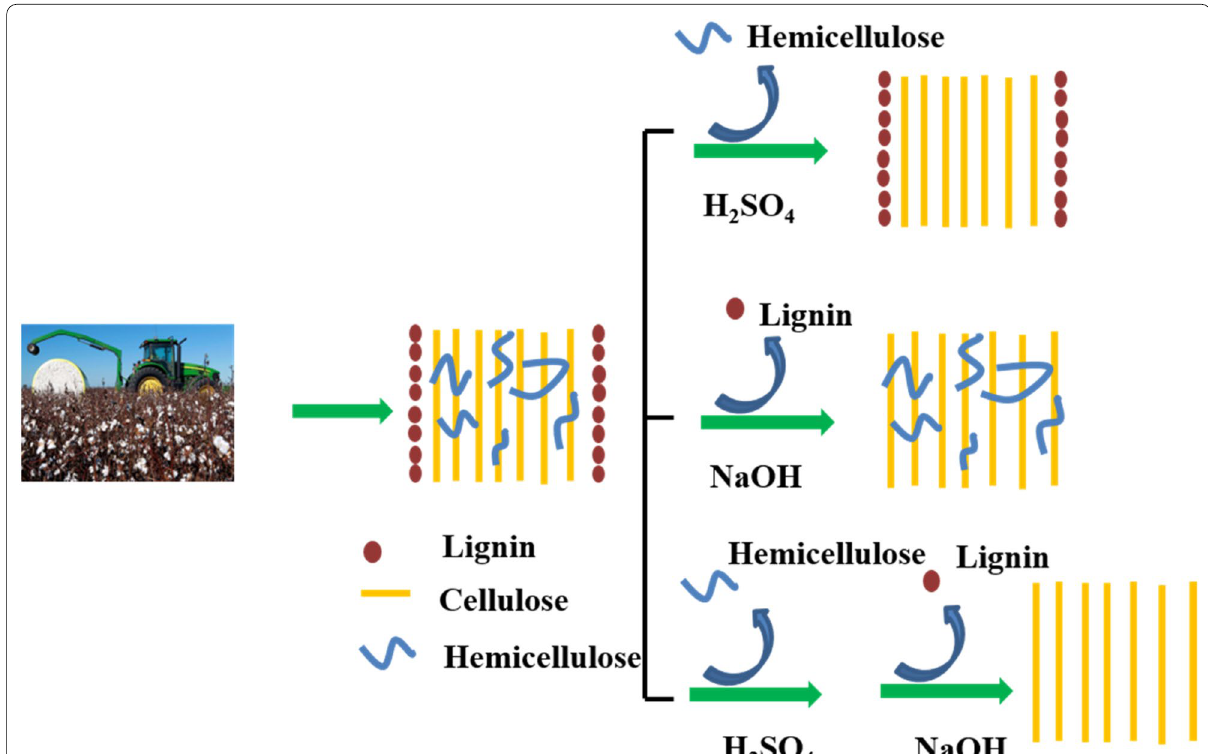
Fig. 2 Diagram of influence of acid and base (or both) pretreatment on cotton stalk